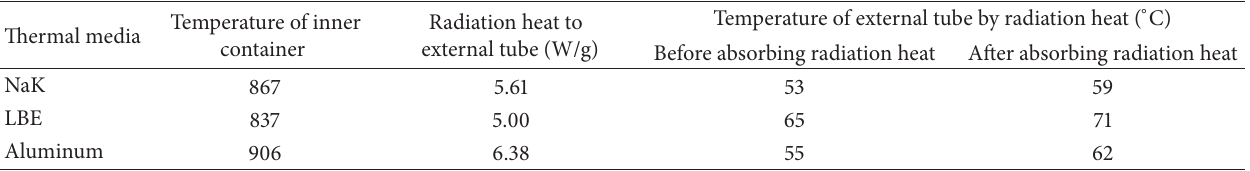
Table 3: Temperature changes of the external tube by radiation